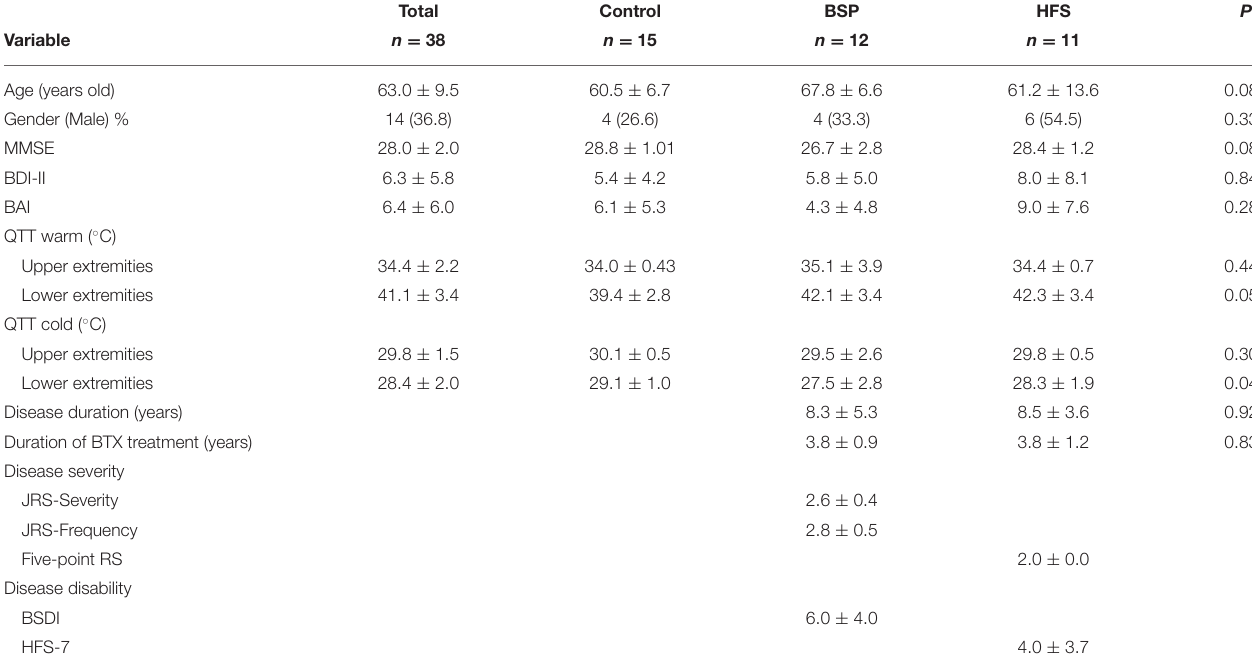
TABLE 1 | Clinical characteristics of the study